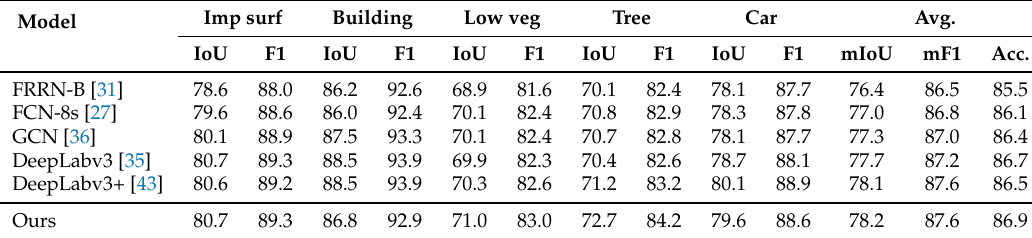
Figure 9. Precision-recall (PR) curves of all the comparing deep learning models on Potsdam local evaluation. Categories from left to right: impervious surface (imp surf), building, low vegetation (low veg), tree, car. Table 2. Local evaluation results on ISPRS Potsdam dataset. Imp surf: impevious surfaces. Low veg: low vegetation. MIoU: average of five objects’ IoUs. MF1: acerage of five obejects’ F1 scores. Acc.: overall